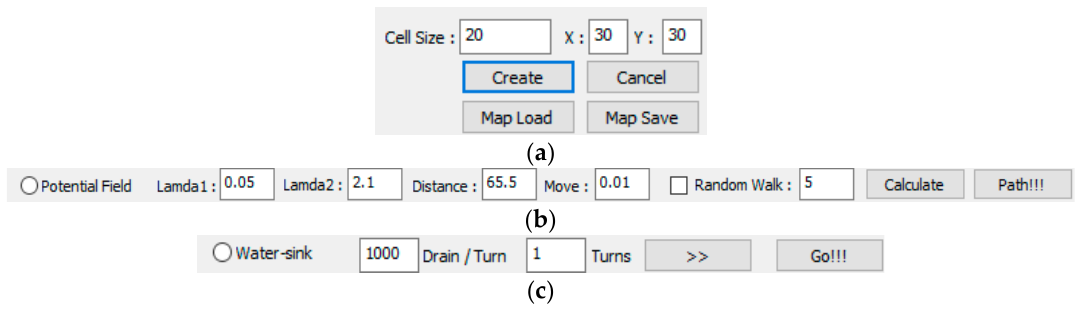
Figure 10. Parameter adjustment of experimental simulator: ( a ) map creation part; ( b ) potential field part; and, ( c ) water sink model part.